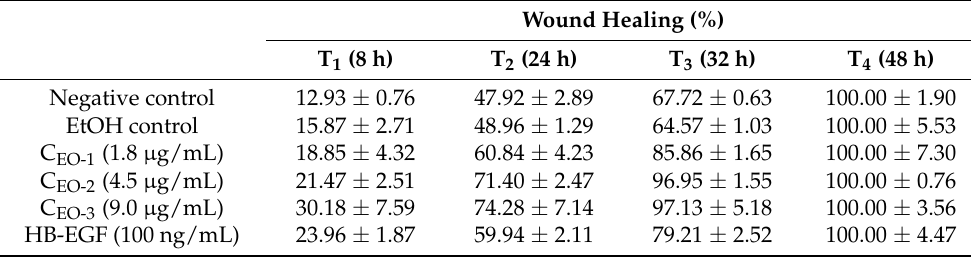
Table 6. Wound healing determination at 8 h, 24 h, 32 h and 48 h.